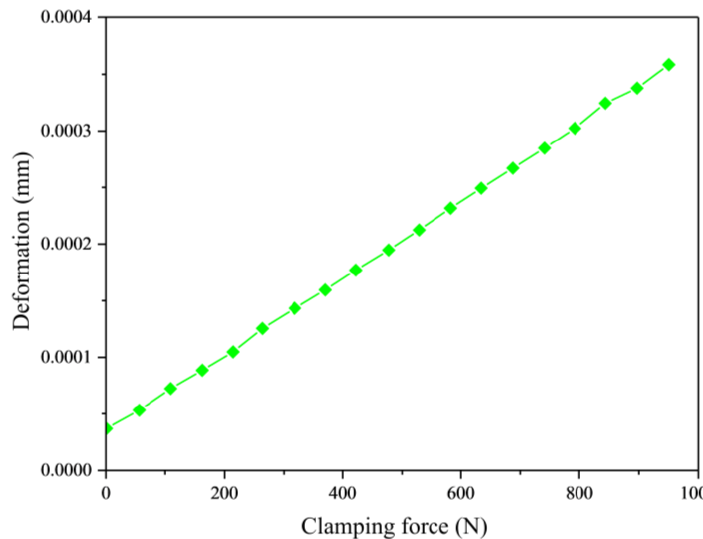
Figure 7. Relationship between clamping force and deformation.